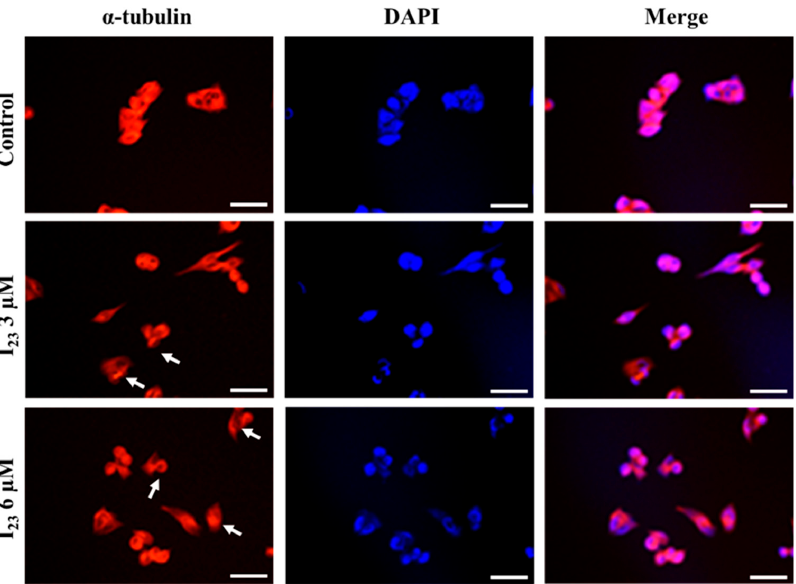
Figure 3. Effects of compound I 23 on the cellular microtubule network were visualized by immuno- fluorescence assay. HepG2 cells were treated with vehicle control 0.1% DMSO, 3 μ M and 6 μ M I 23 for 24 h. Then, cells were fixed and stained with anti- α -tubulin antibody (red) and counterstained with DAPI (blue). Detection of the fixed and stained cells was performed using fluorescence micro- scope. Scale bars are 50 μ